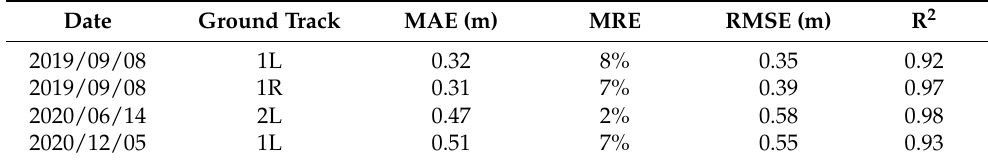
Table 1. Validation of ICESat-2 bathymetry results in Oahu area.